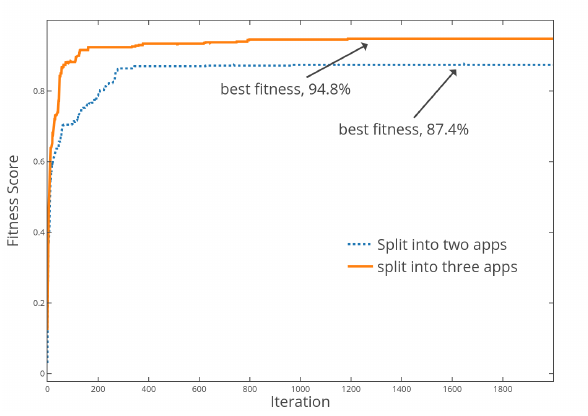
Figure 2. Best fitness score of